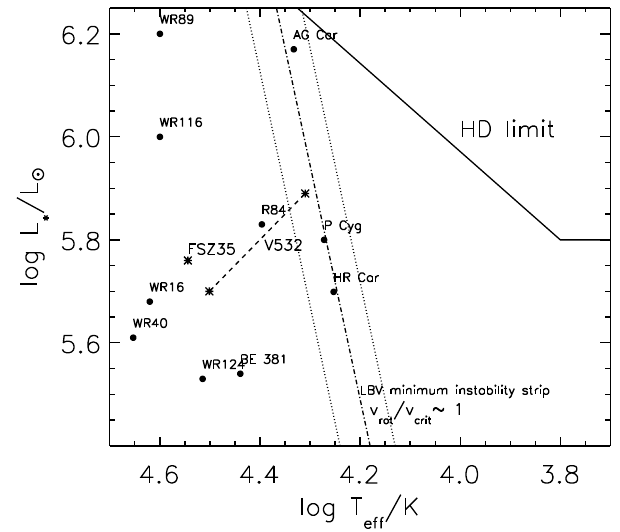
Fig. 2. A schematic presentation of the upper part of the HR Diagram. The position of the LBV minimum instability strip is plotted as a dashed-dotted line. The location of the Humphreys-Davidson limit (Humphreys & Davidson 1994) is shown as the solid line. The dashed line shows the transit of V532 across the instability strip. WN9 (BE381, R84), WN8 (WR124, WR16, WR40, FSZ35) and LBV (AG Car, HR Car, P Cyg) stars are shown for comparison. Data on these objects were taken from Crowther & Smith (1997), Crowther & Smith (1997), Crowther et al. (1999), Herald et al. (2001), Herald et al. (2001), Maryeva & Abolmasov (2012b), Groh et al. (2009b), Groh et al. (2009a), Najarro